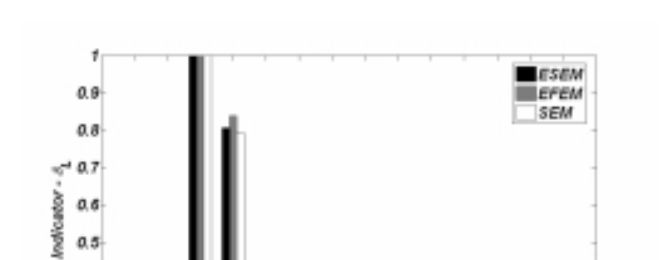
Fig. 7. Coupled beam structures.